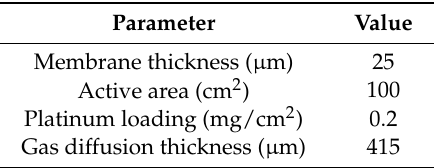
Table 1. Technical details of the PEM fuel cell system.